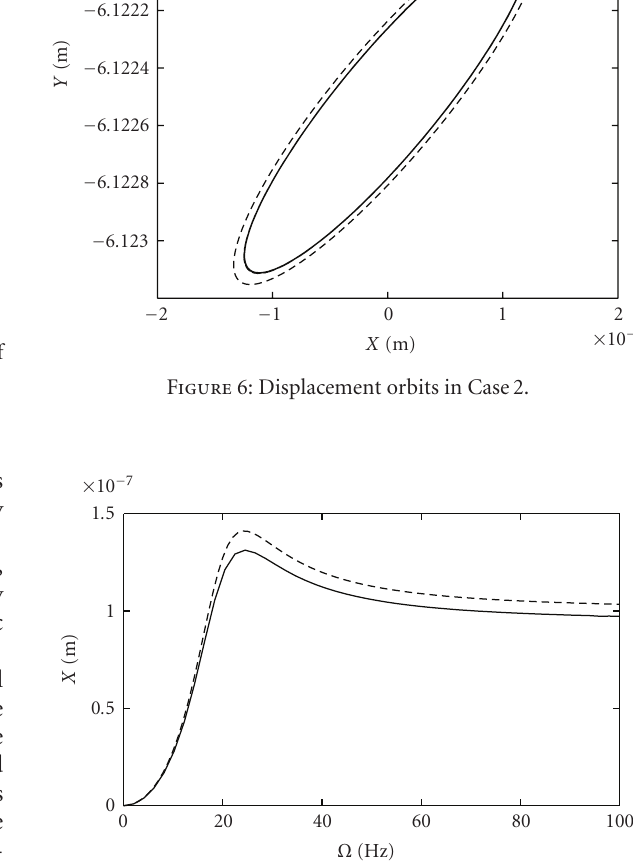
Figure 7: Maximum amplitude as function of spin